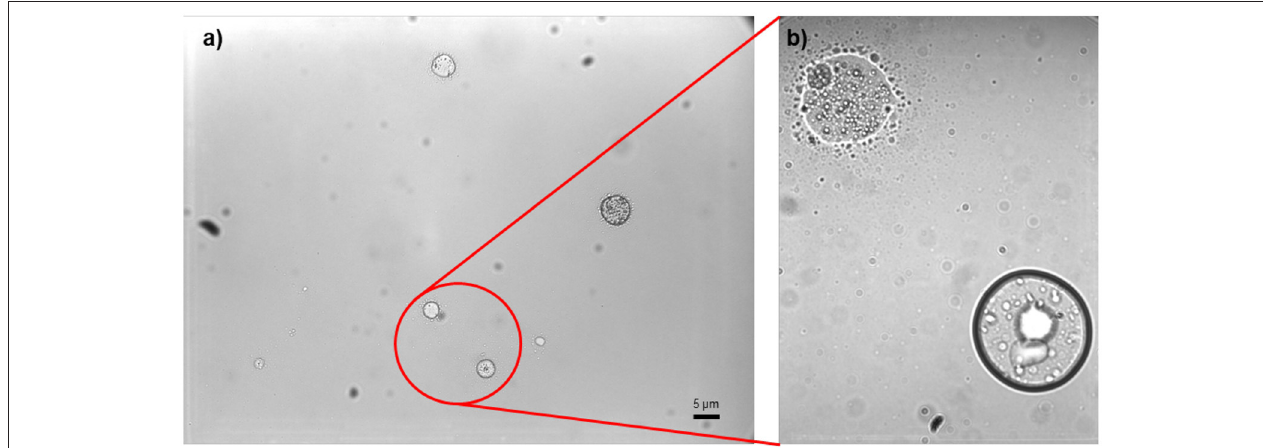
FIGURE 1 | Phase contrast light microscope image of the biomimetic emulsion at 10 × (a) and 50 × (b) magnifications. Insect feet fluids are usually emulsions at the nanoscale: one cannot see the second phase in optical microscope, only in an electron microscope (SEM, TEM) or in an atomic force microscope (AFM).